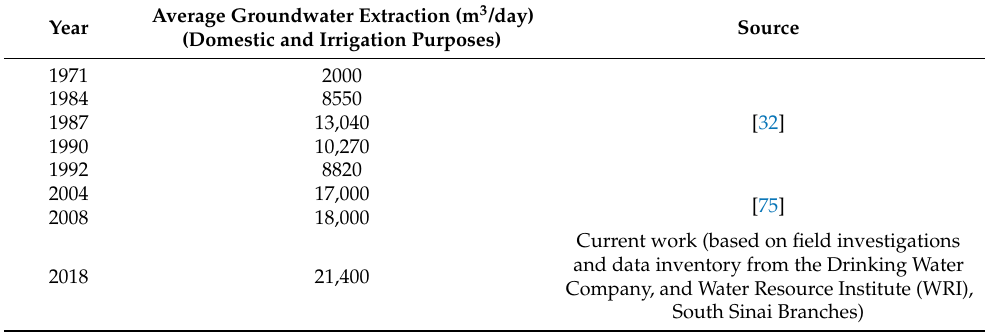
Table 5. Average groundwater extraction over the